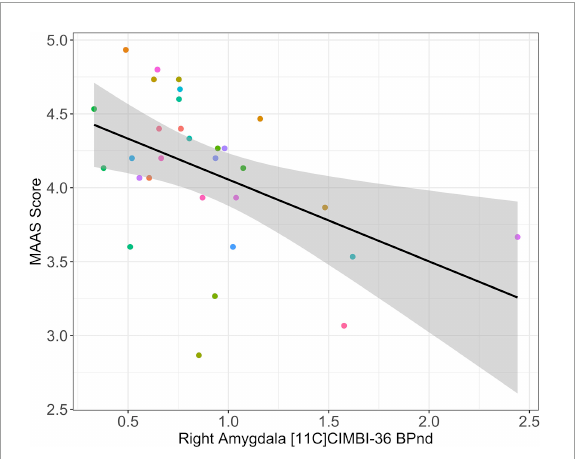
FIGURE1 Change in Mindful Attention and Awareness Scale (MAAS) score following psilocybin administration from baseline to 3-month follow-up in the full sample ( n = 46). Colored lines: Individual values; middle black dot: mean; error bar: SD. No participants had a total MAAS score < 2. Maximum possible MAAS score = 6.